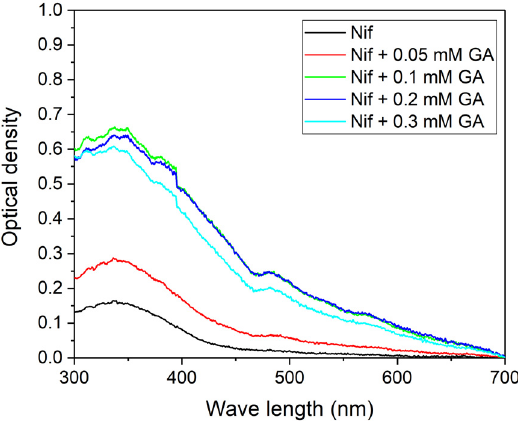
Figure 4. Optical absorption spectra of the mixture nifedipine + GA at pH value 4.9 after 24 hours of stirring. The GA absorption is subtracted from all spectra.